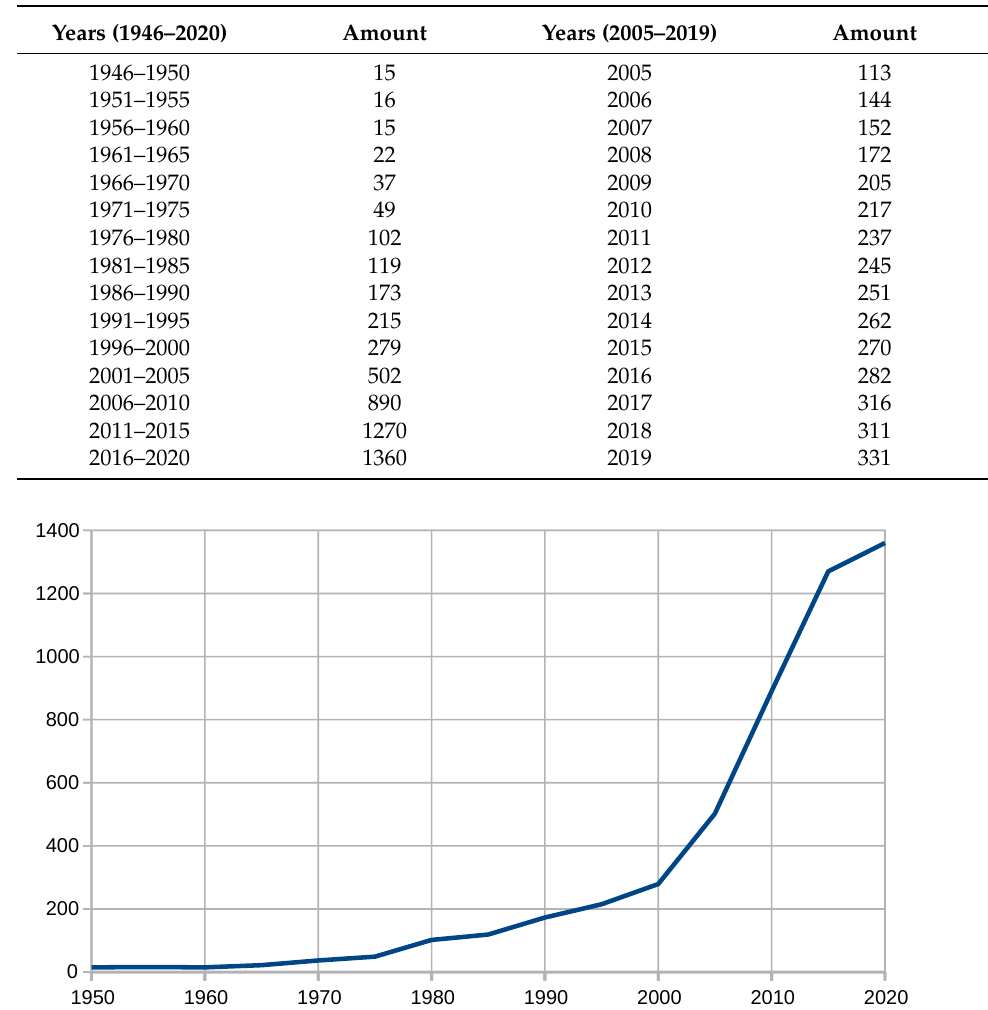
Figure 2. Number of publications on insect radar from 1946 to 2020 (five-year